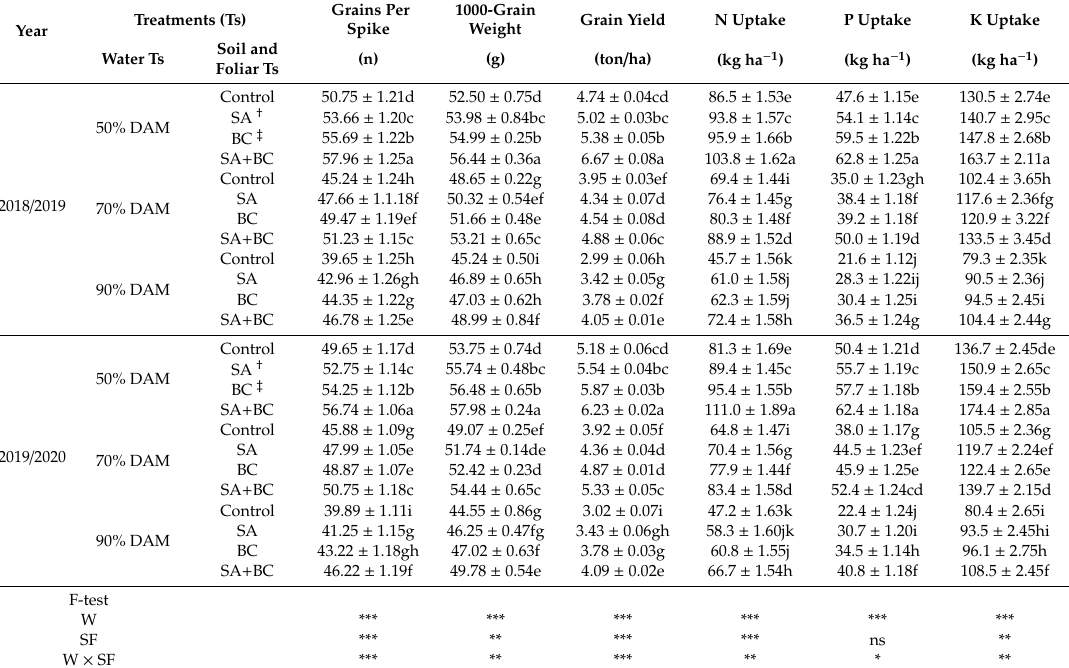
Table 4. Yield, yield components, and nutrient uptake of wheat plants irrigated with (50%, 70%, and 90% DAM) in saline sodic soil treated by salicylic acid and biochar during two growing